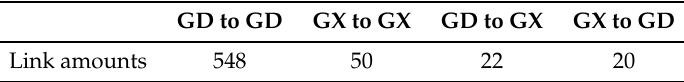
Table 3. Interaction amounts.